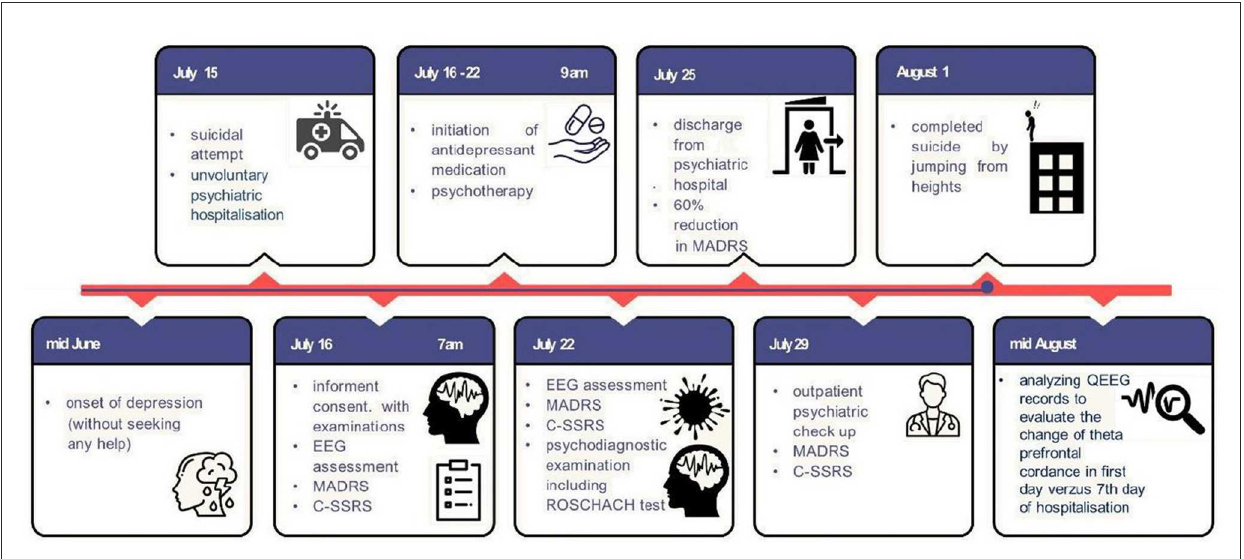
FIGURE1 Timeline of presented case report. EEG, Electroencephalography; MADRS, Montgomery–Asberg Depression Rating Scale; C-SSRS, Columbia–Suicide Severity Rating Scale; QEEG, Quantitative Electroencephalography.